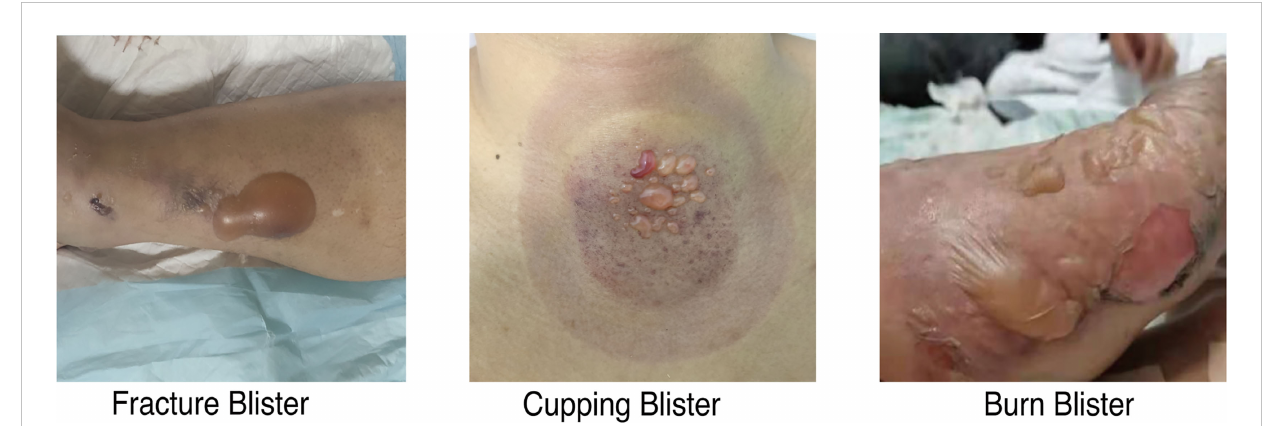
FIGURE 1 Images of blisters from fracture, burn, and cupping patients. Fracture blisters appear 24 to 48 hours after the fracture injury, and their exterior is similar to burn blisters and cupping